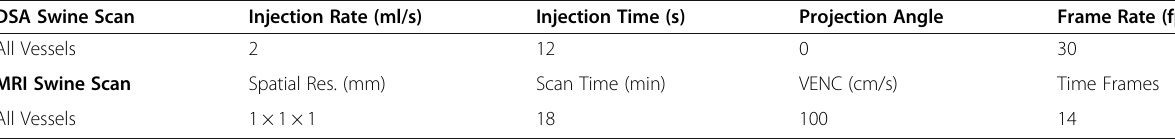
Table 2 In Vivo Imaging Parameters DSA Swine Scan